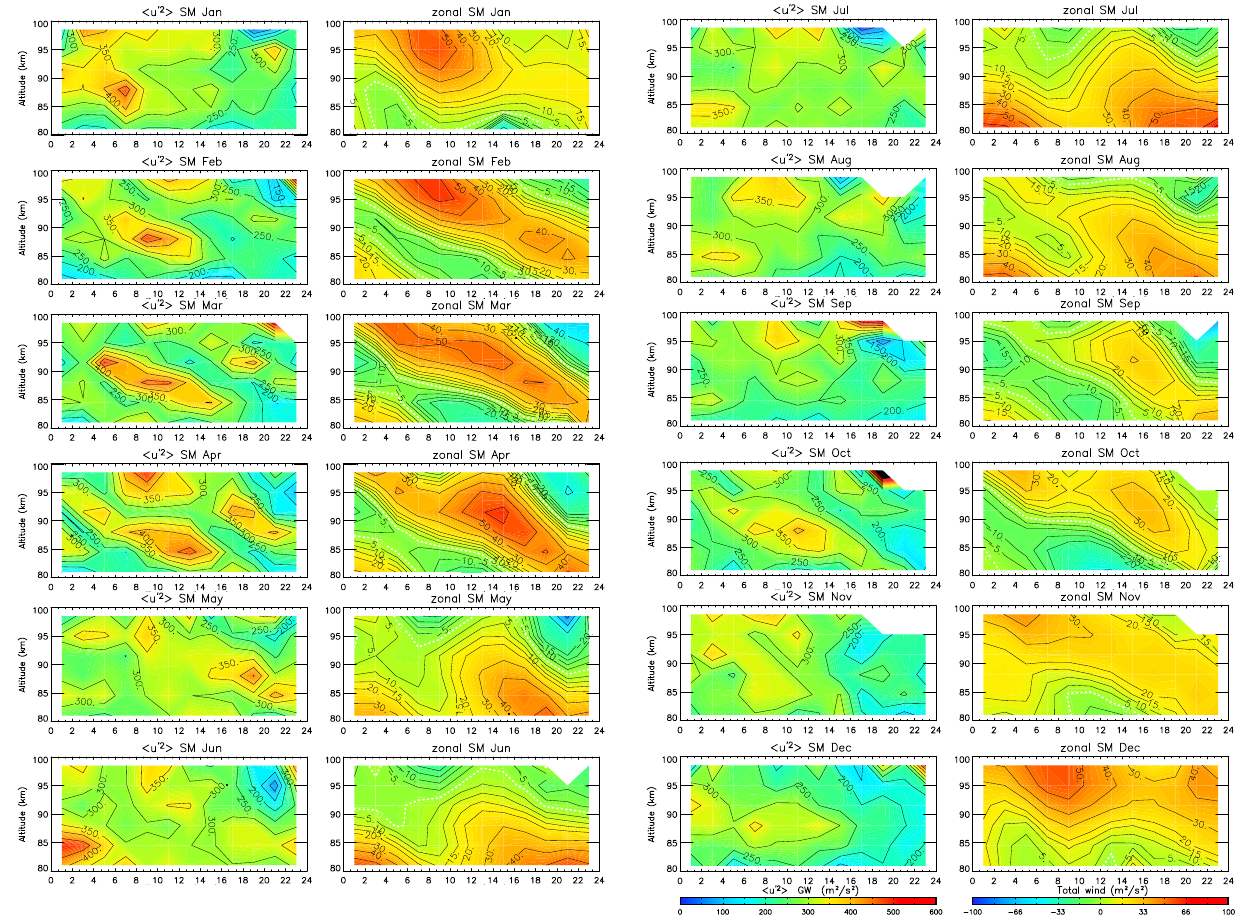
Fig. 9. Zonal component of variances (left side) and the total wind (right side) averaged from 2005–2009 over Santa Maria. All panels show the height/time variation of their respective variable. The altitude is measured in km, the x axis represents Universal Time (UT), and each line of the variances contour plot corresponds to 50m 2 s − 2 . The total wind is measured in ms − 1 and the dashed line indicates where the values are